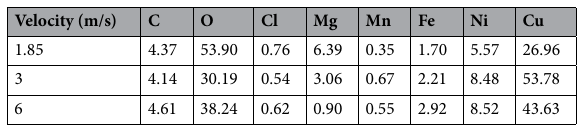
Table 6. The elemental composition of BM of B10 alloy under different seawater flow rates.